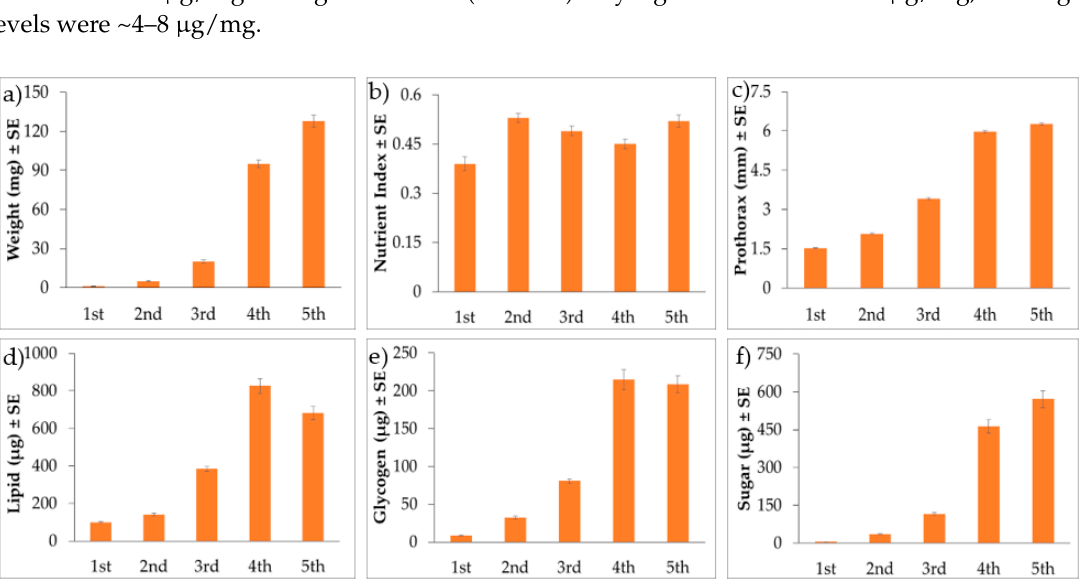
Figure 2. Average ( ± SE) of weight ( a ); nutrient index ( b ); prothorax ( c ); lipid ( d ); glycogen ( e ) and sugar ( f ) of the five nymphal instars of BMSB collected in 2015. Nutrient levels per wet weight in Table S1.